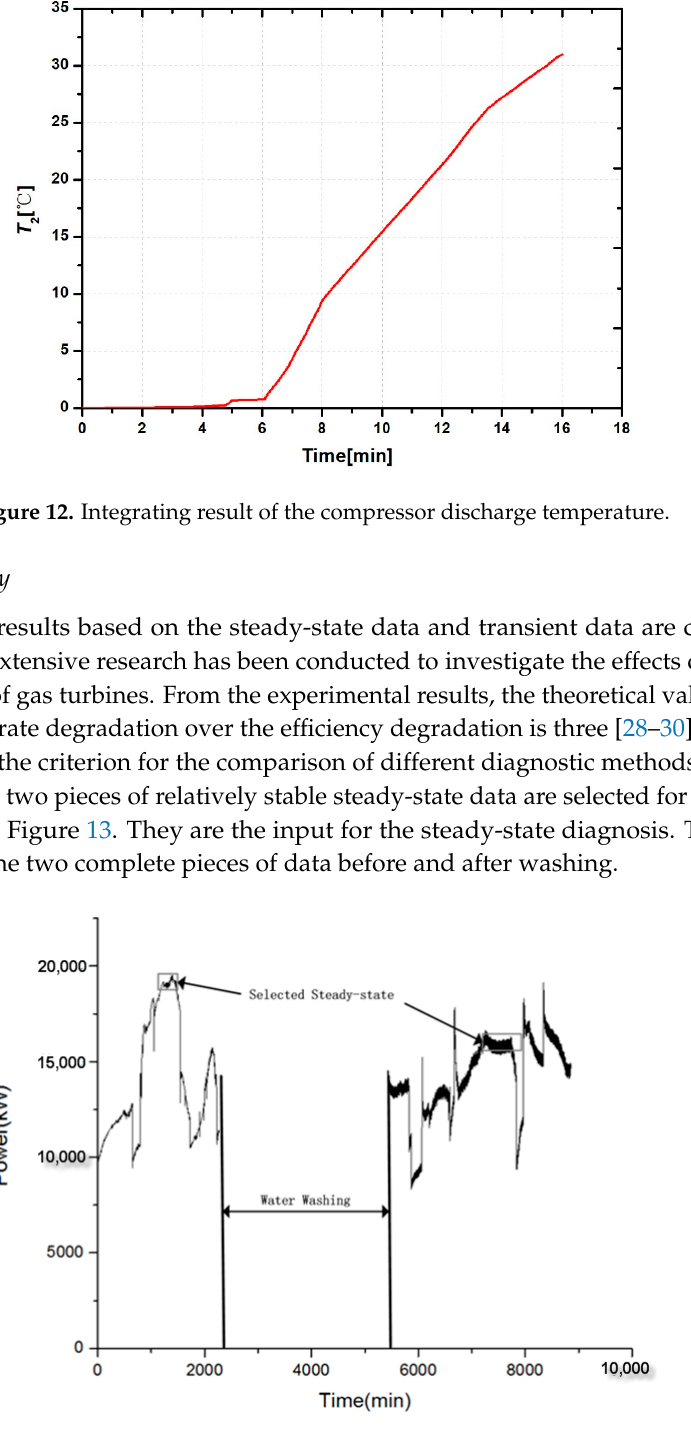
Figure 13. Selected working condition for diagnosis.